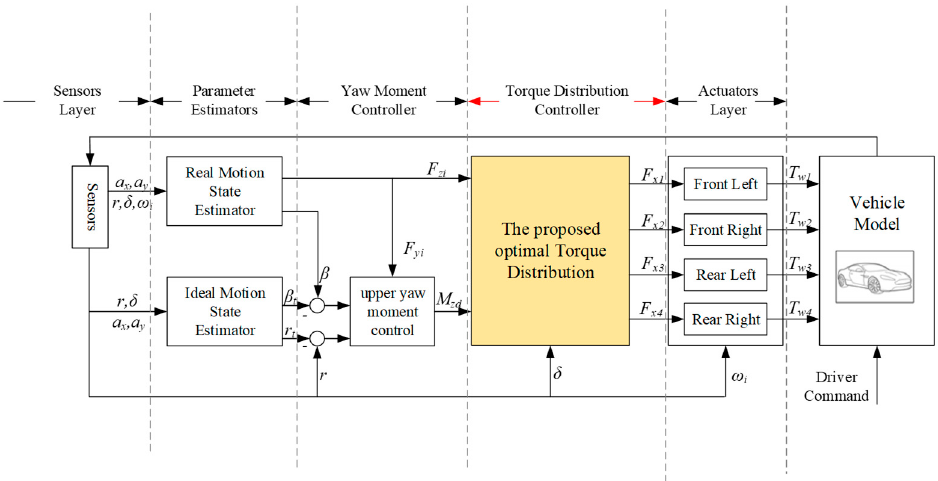
Figure 2. Hierarchical direct yaw moment control (DYC) system.